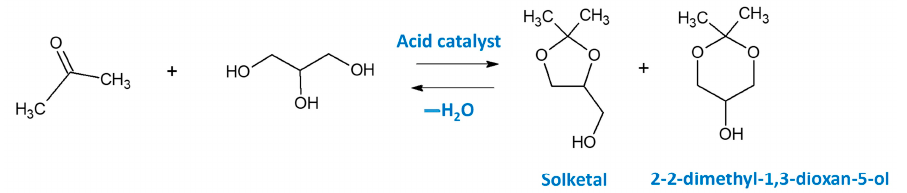
Figure 27. Acetalization of glycerol with acetone over acid catalysts. Adapted with permission from ref. [231]. Copyright © 2014, American Chemical Society.